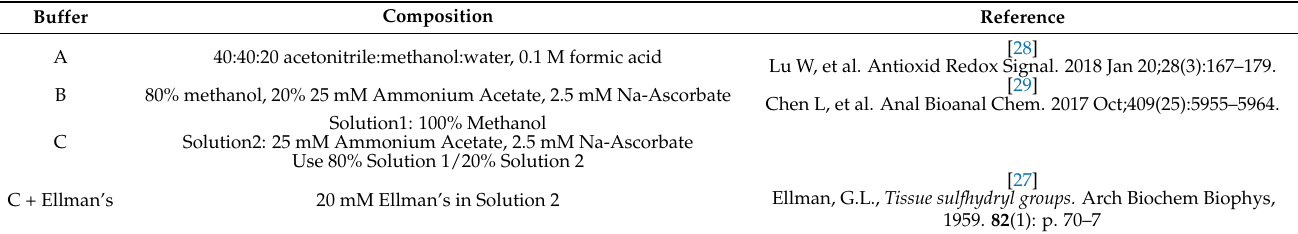
Table 3. Extraction buffer composition.